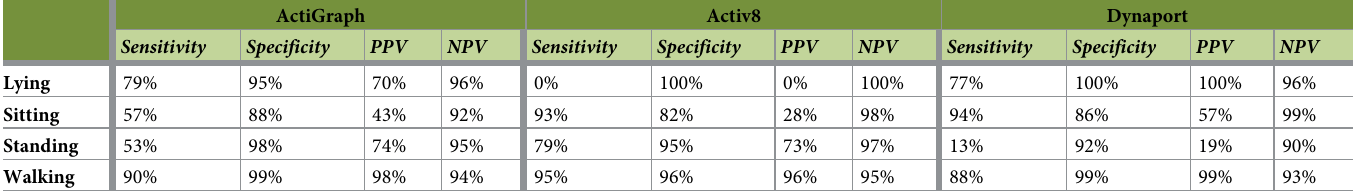
Table 4. Validity � outcomes per accelerometer, per category.